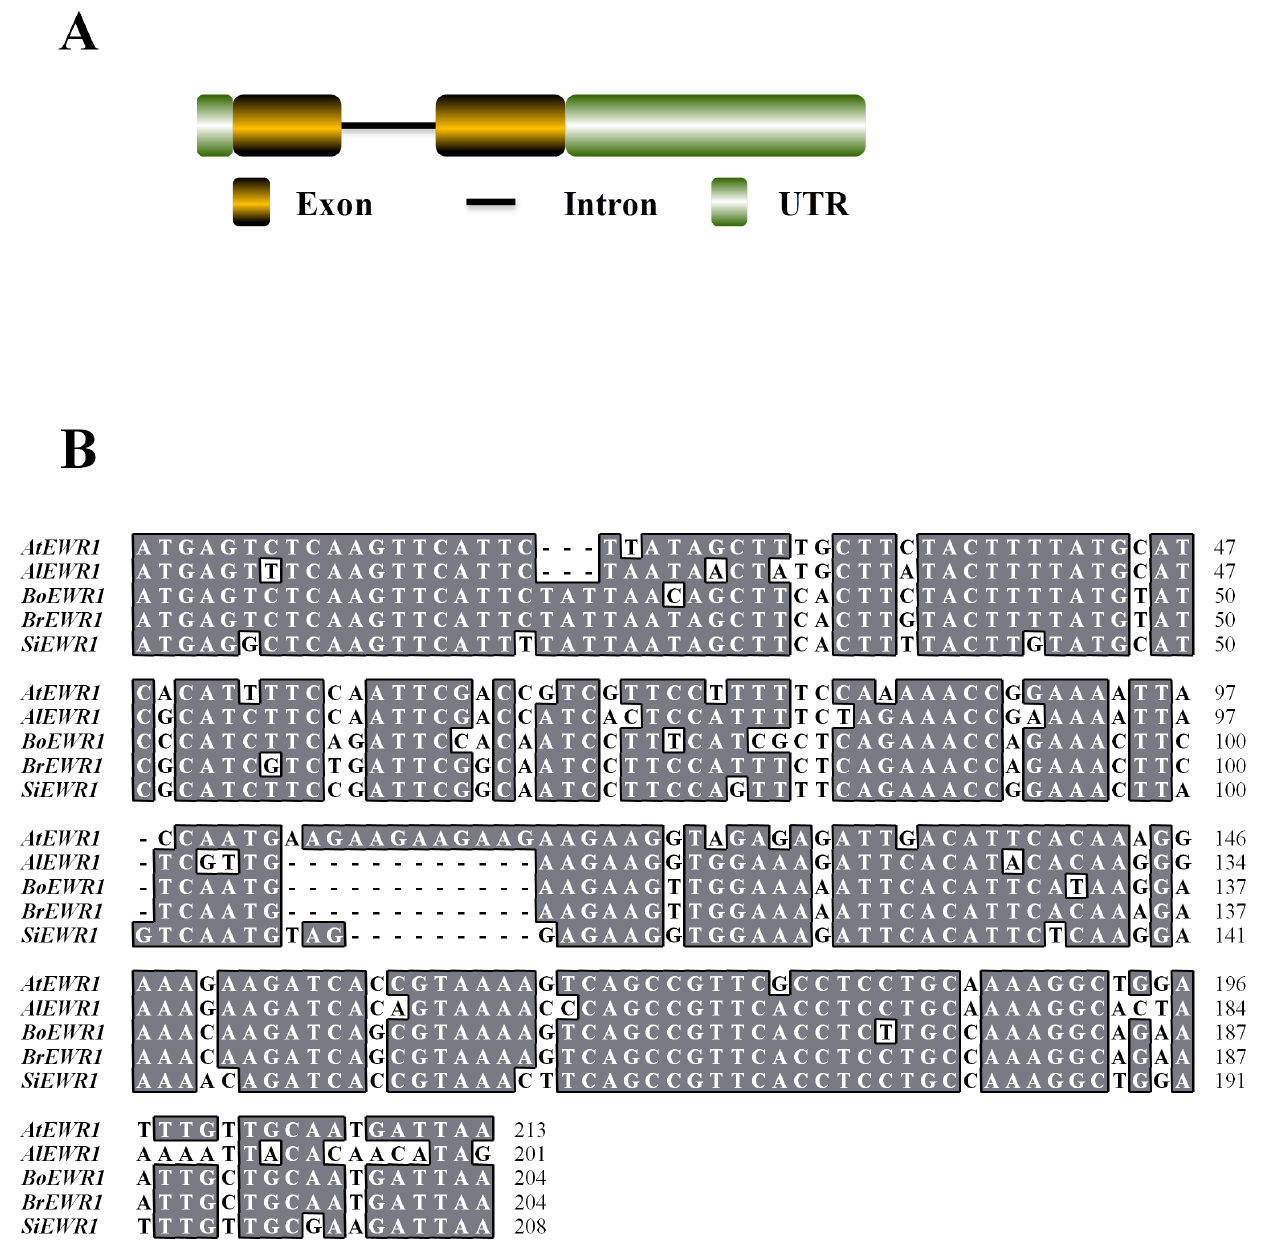
Figure 6. EWR1 is highly conserved in Brassicaceae . (A) Schematic representation of the full-length genomic DNA sequence of EWR1 gene. (B) Nucleotide sequence alignment of AtEWR1 and its homologs from Arabidopsis lyrata ( AlEWR1 ), Brassica oleracea var. gemmifera ( BoEWR1 ), Brassica rapa (BrEWR1) , and Sisymbrium irio ( SiEWR1 ).